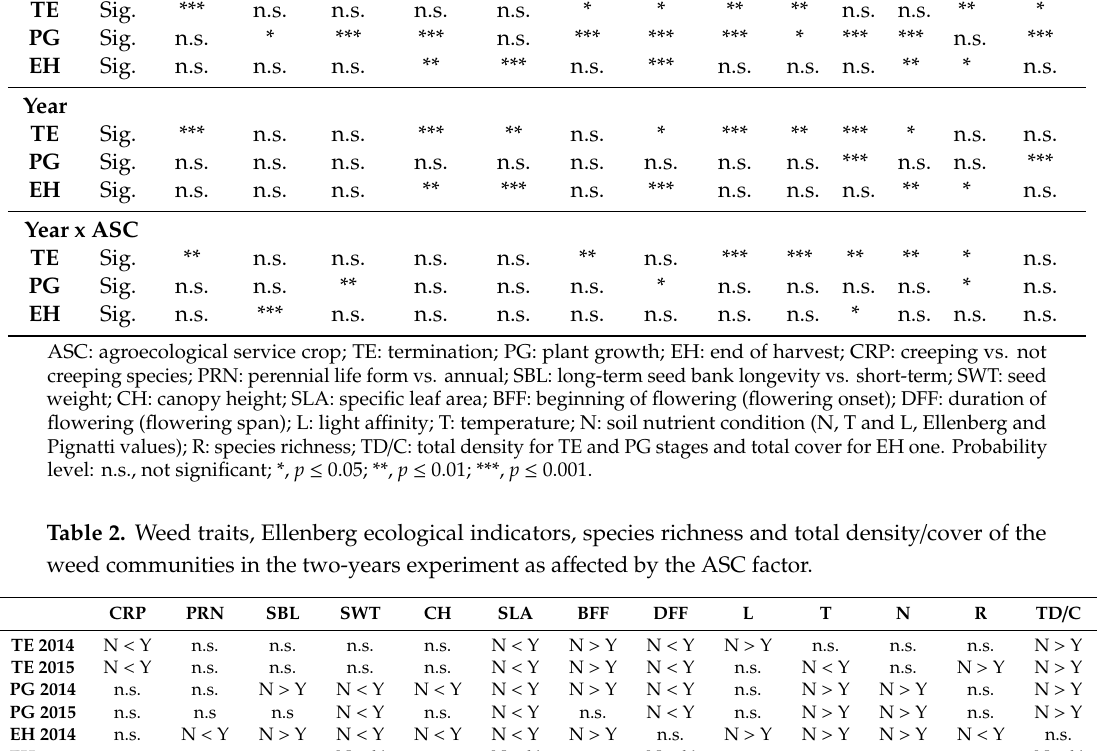
Table 1. Results of linear mixed model for tested parameters in the two-years experiment as a ff ected by the year, and the ASC factors. CRP PRN SBL SWT CH ASC TE Sig. *** PG Sig. EH Sig. Year TE Sig. *** PG Sig. EH Sig. n.s. Year x ASC TE Sig. ** PG Sig. n.s. EH Sig.